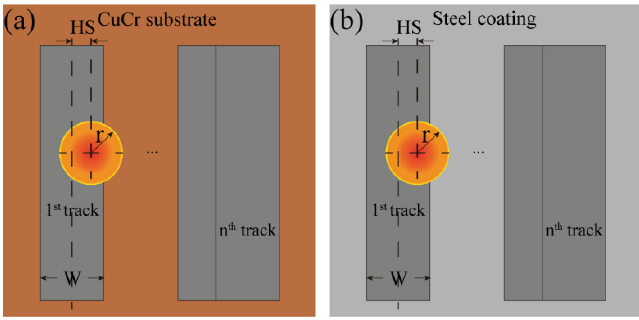
Figure 5. Evolution of the substrate laser absorption: ( a ) the first layer except for the first track; ( b ) the second layer and above.